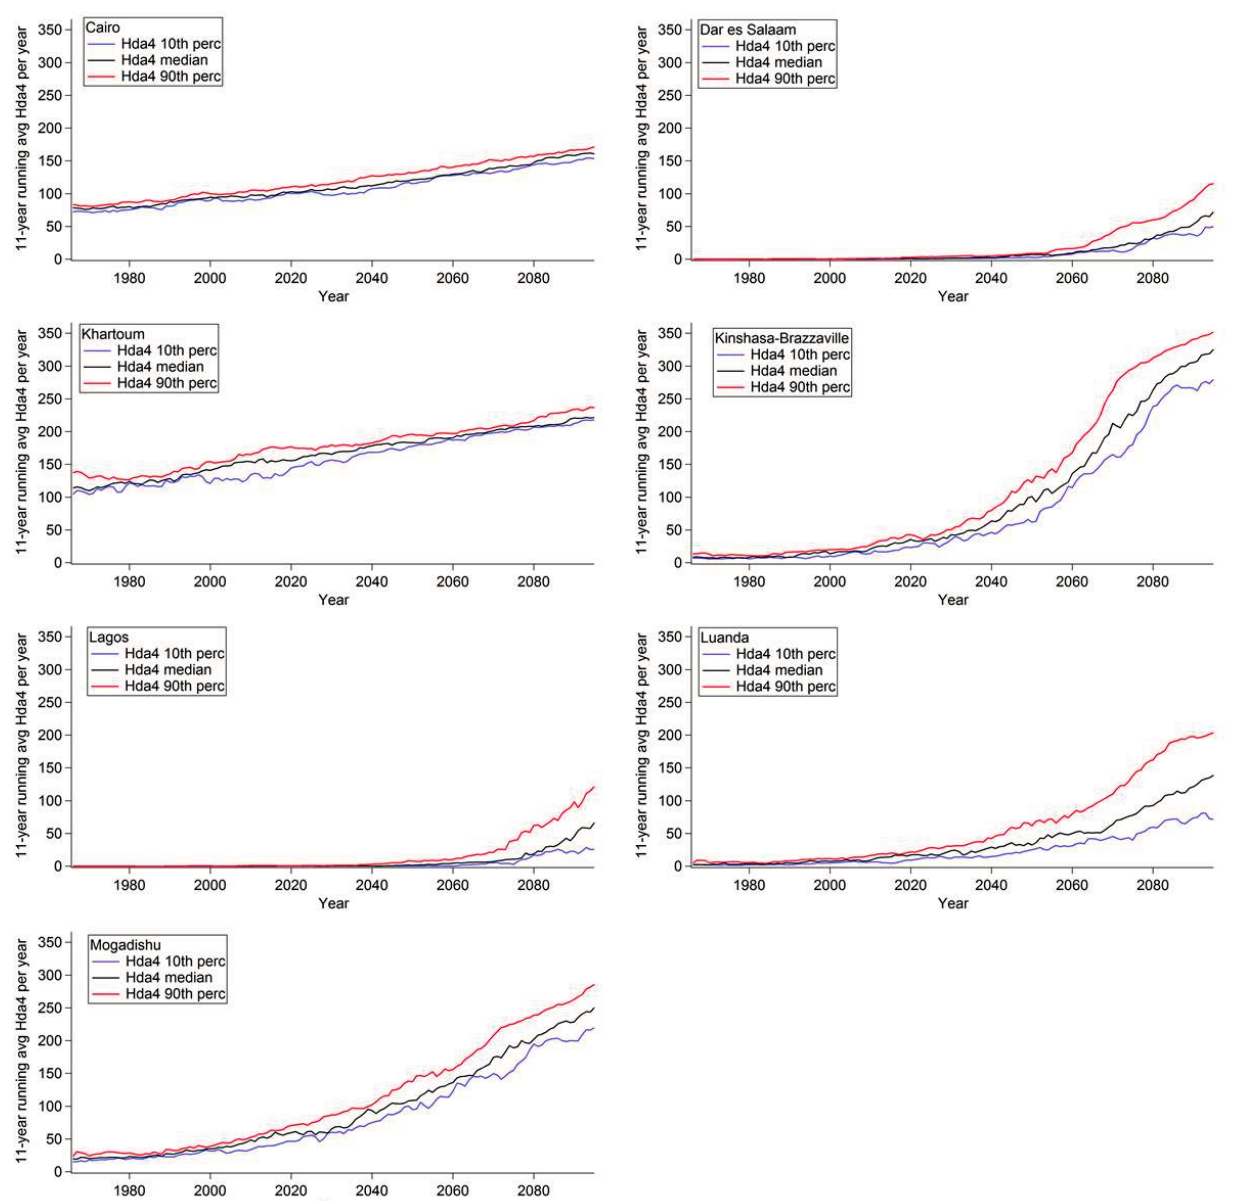
Figure 6. Eleven-year moving average of the number of Hda4 per year in selected cities in Africa. The ensemble 10th percentile (blue), the ensemble median (black) and the ensemble 90th percentile (red) of number of days per year are